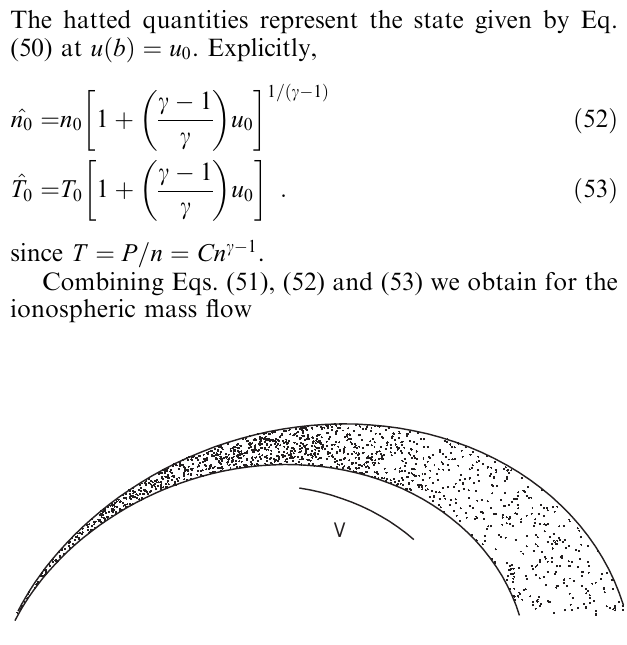
Fig. 8. If the potential drop resides at high enough altitude, it compresses the electron plasma beneath it in such a way that the plasma states above and below the drop are independent of exact geometry of the flux tube. If the ionospheric bottom of the flux tube is narrow enough, the fact that plasma starts escaping into the ionosphere does not appreciably alter the compression by the potential drop V